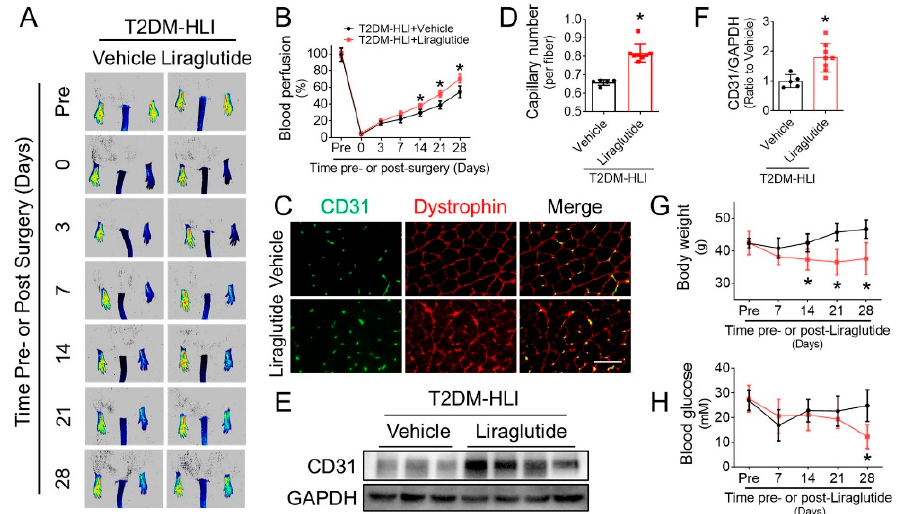
Figure 1. Liraglutide improves blood perfusion and angiogenesis in ischemic hindlimbs of T2DM mice. The proangiogenic effect of liraglutide in diabetic ischemic tissues was investigated in db/db mice. The blood perfusion in ischemic hindlimb of db/db mice treated with or without liraglutide was evaluated using a PeriCam PSI ( A ), and quantified using Image J ( B ). At the 28th day after HLI surgery, CD31-positive capillaries in gastrocnemius muscle tissue of ischemic hind limbs were detected by immunofluorescent staining ( C ), and presented as CD31-positive capillaries per muscle fiber identified by dystrophin staining ( D ). CD31 expression in ischemic hind limb was also detected by Western blot ( E ) and quantified using Imagequant ( F ), glyceraldehyde 3-phosphate dehydrogenase (GAPDH) was used as loading control. Blood glucose ( G ) and body weight ( H ) were monitored before and after HLI surgery. n = 5 or 8 mice per group. Data shown in graphs presented as mean ± S.D. * p < 0.05 vs vehicle group, Bar = 100 µm. T2DM, type 2 diabetes mellitus.